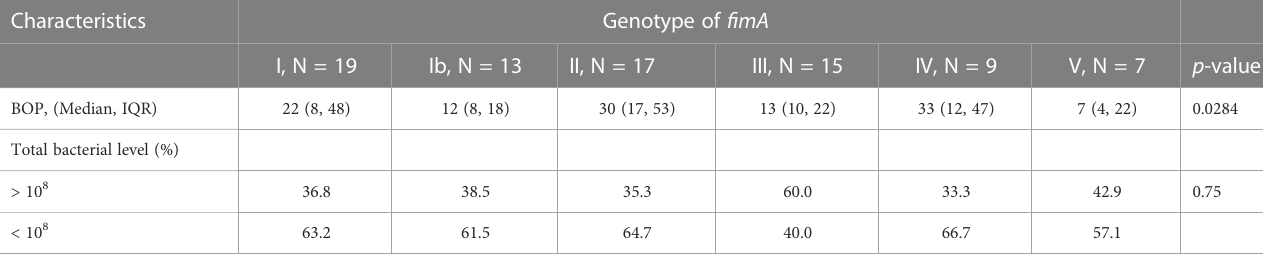
TABLE 7 Correlation between the fi mA genotypes and BOP levels or total bacteria numbers. Characteristics